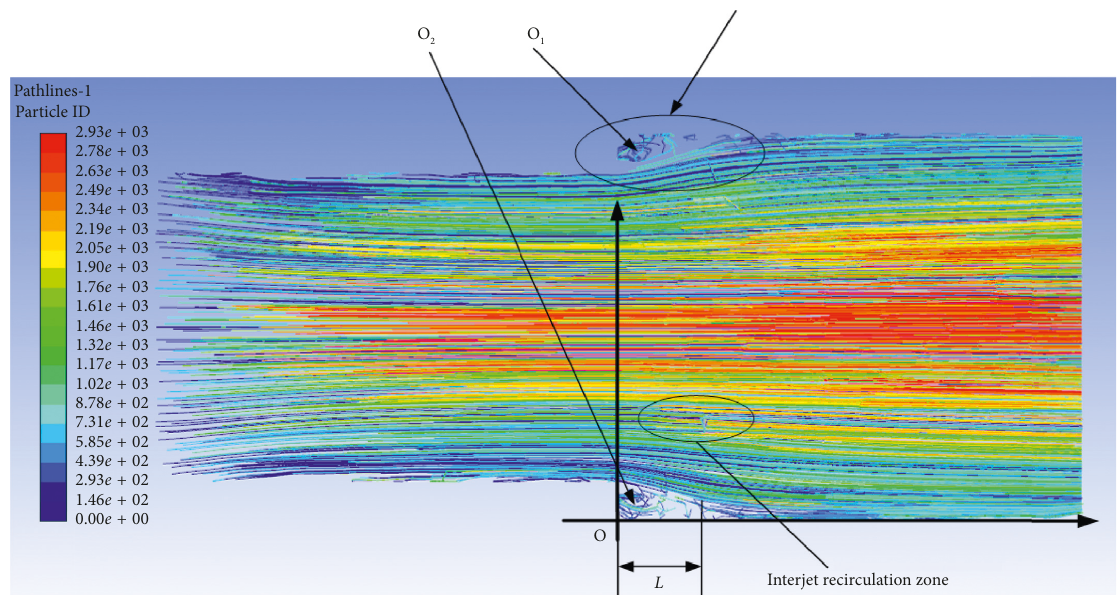
Figure 7: Flow field diagram of the sudden extension of cross section.